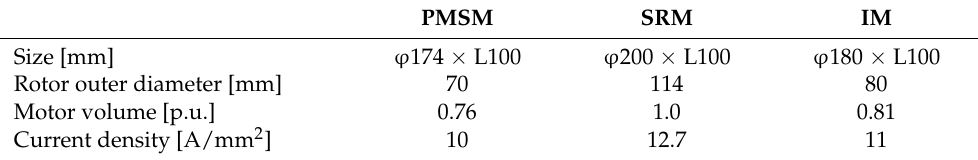
Table 6. Comparison of motor volume.